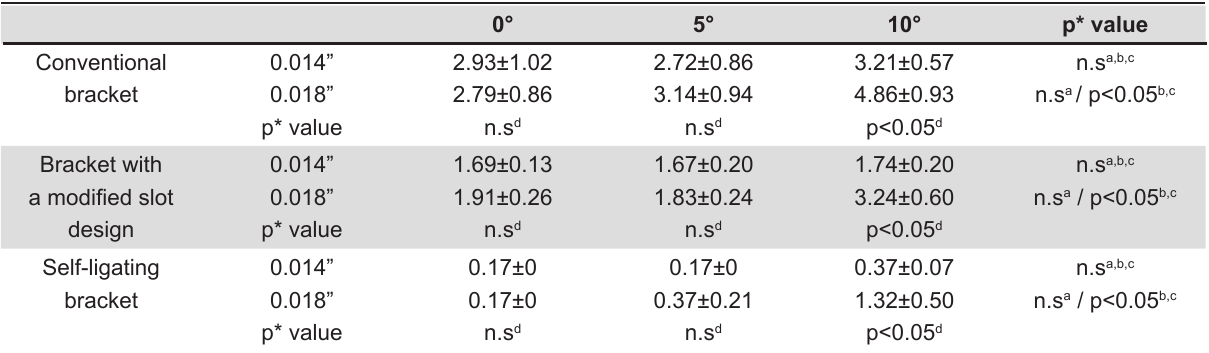
*p values were obtained by two way ANOVA followed by Bonferroni’s post hoc test.